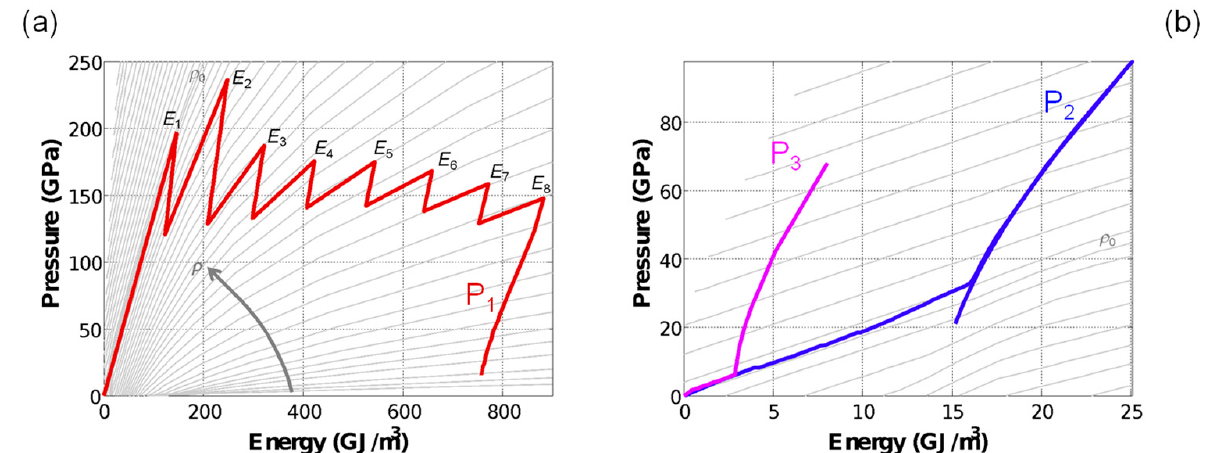
Figure 14. Equation of state of tungsten visualized in the pressure versus energy plane varying the density. The diagrams represent the P ‐ E ‐ ρ evolution of three elements: P 1 is situated where there was the maximum of the energy deposition ( a ); P 2 and P 3 are situated far from this region ( b ).